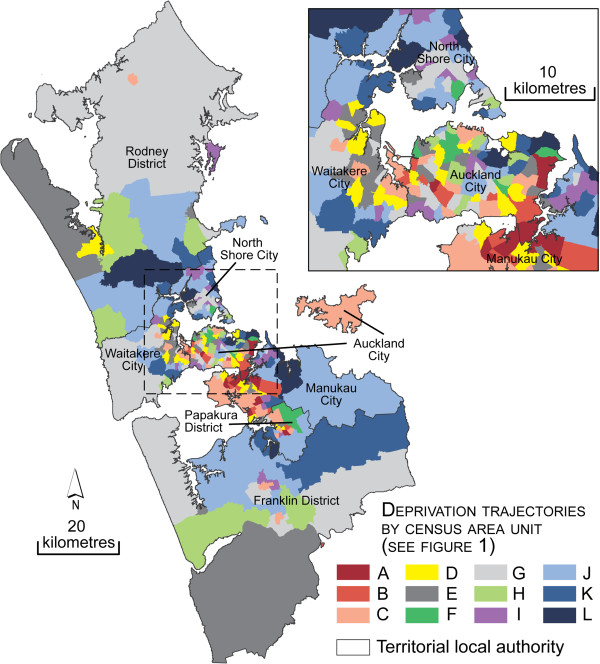
Map of trends of deprivation (1991 and 2006), Auckland region.